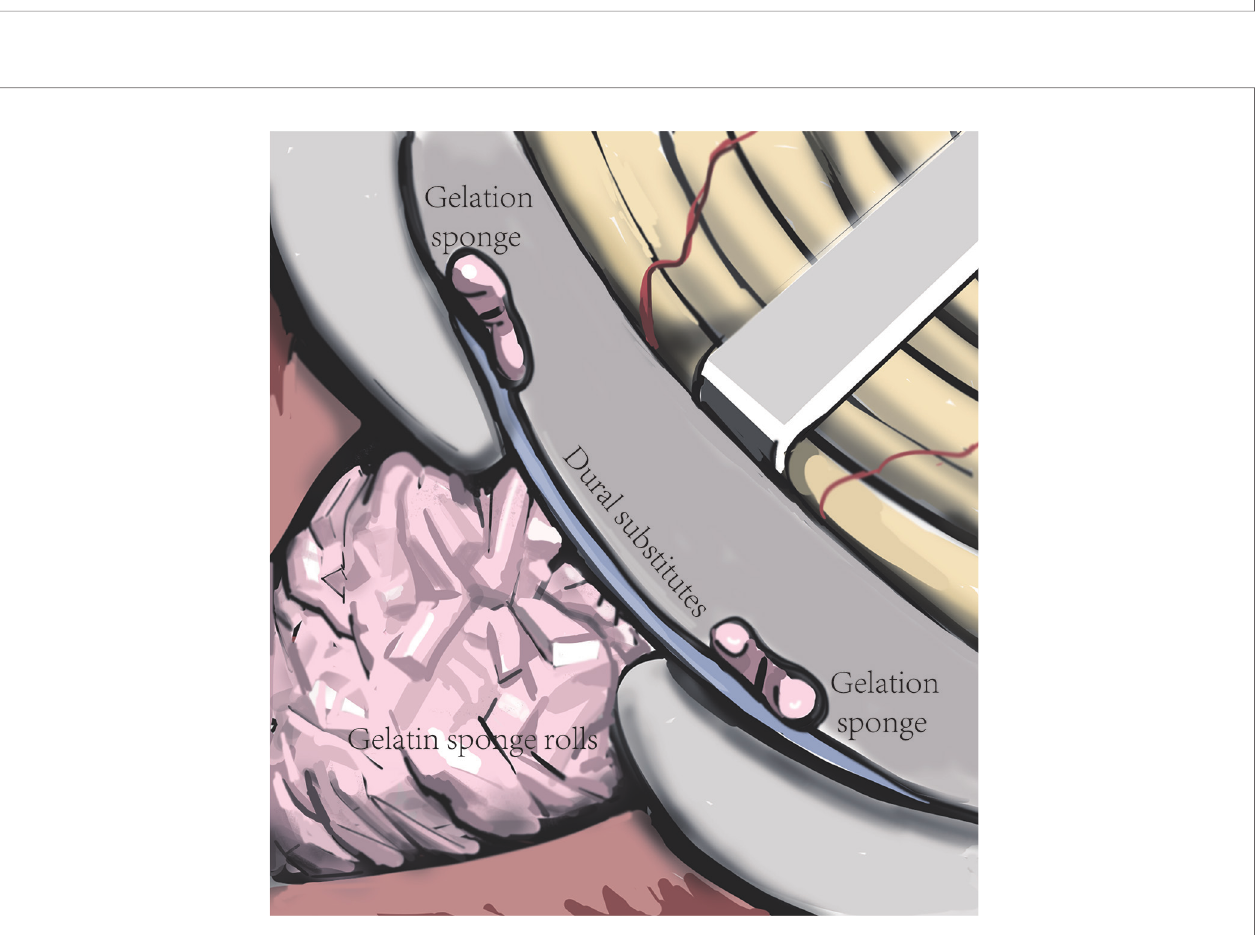
FIGURE 4 | Schematic diagram of the “ sandwich ” skull base reconstruction method. The dural substitute was placed on the inner face of the skull base. The gelatin sponge rolls were fi lled up in the tumor cavity to sustain the dural substitute and one layer of gelatin sponge was cover the margin of the dural substitute to keep it in place.